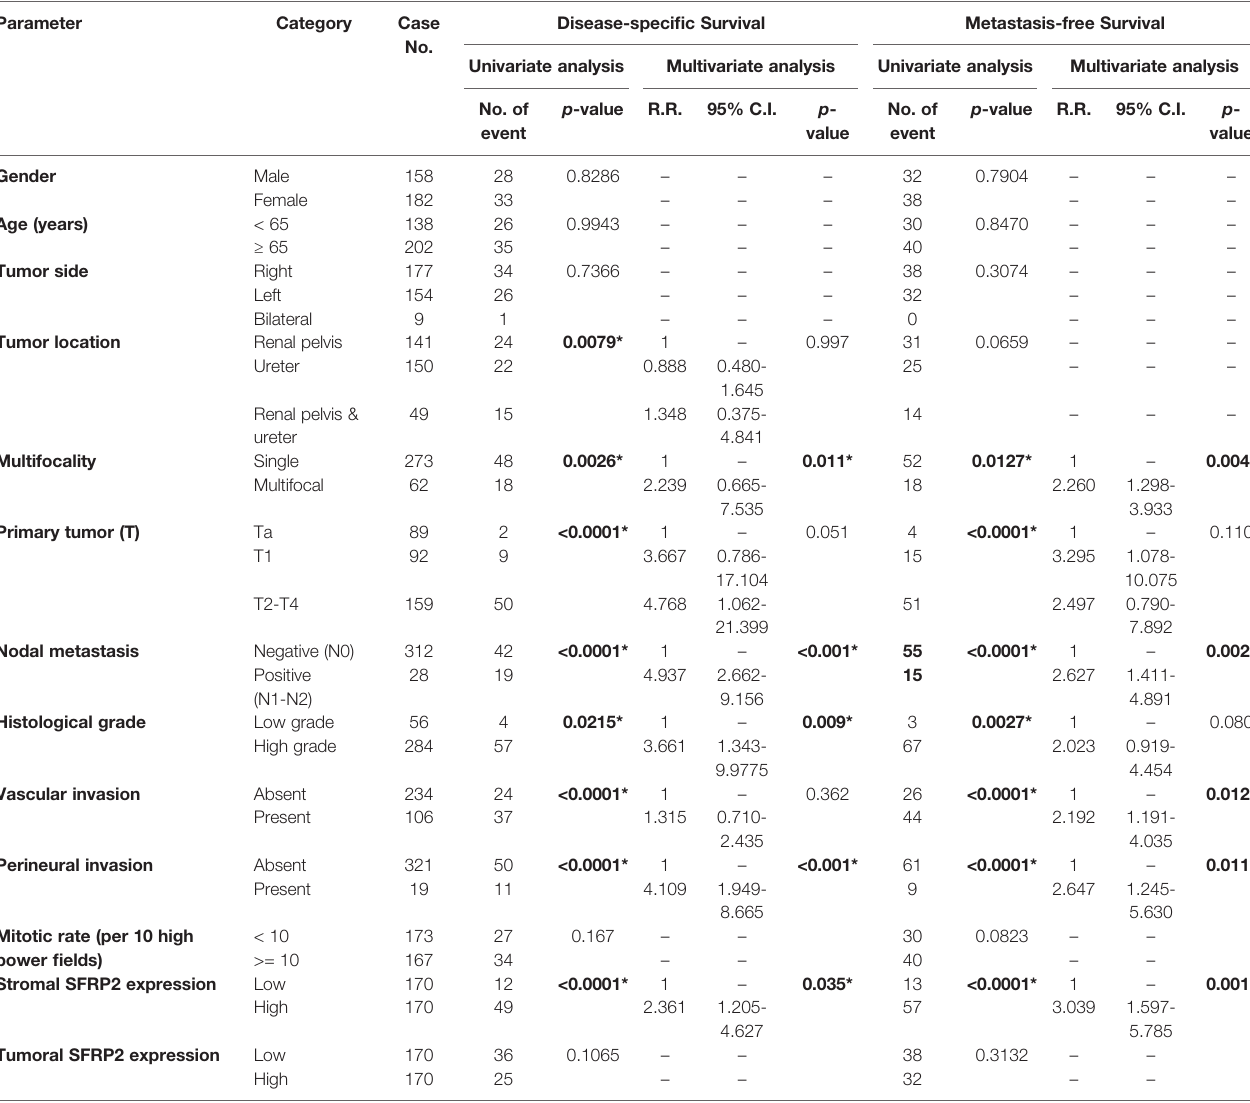
TABLE 4 | Univariate log-rank and multivariate analyses for disease-speci fi c and metastasis-free survivals in upper urinary tract urothelial carcinoma. Parameter